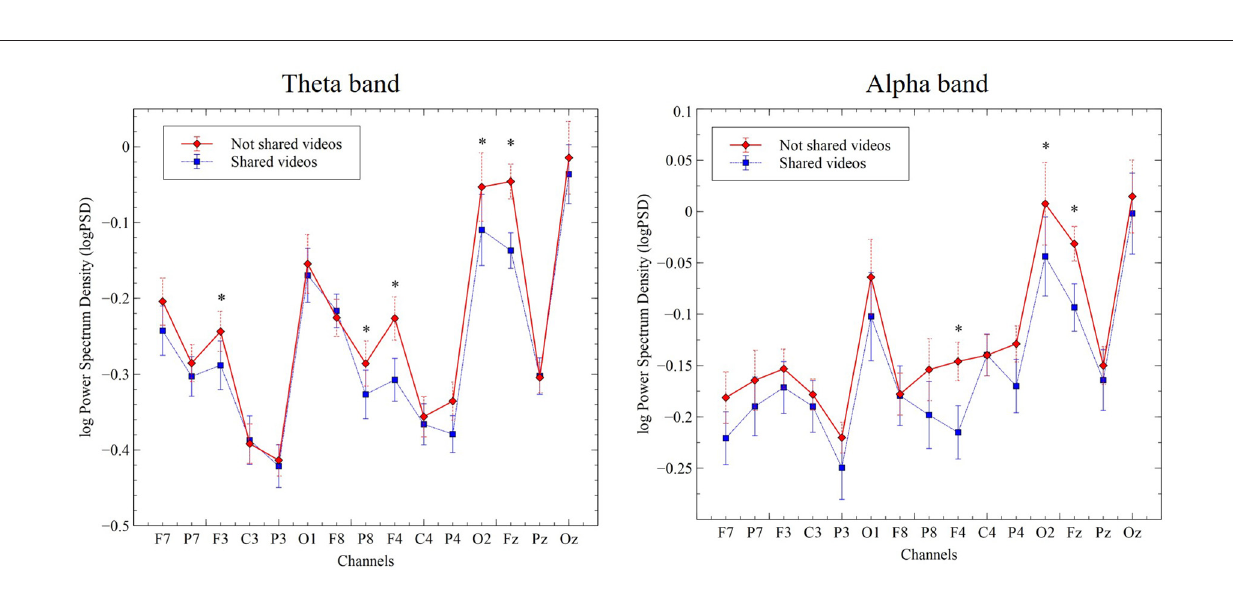
assessed using a permutation test (Ojala and Garriga,